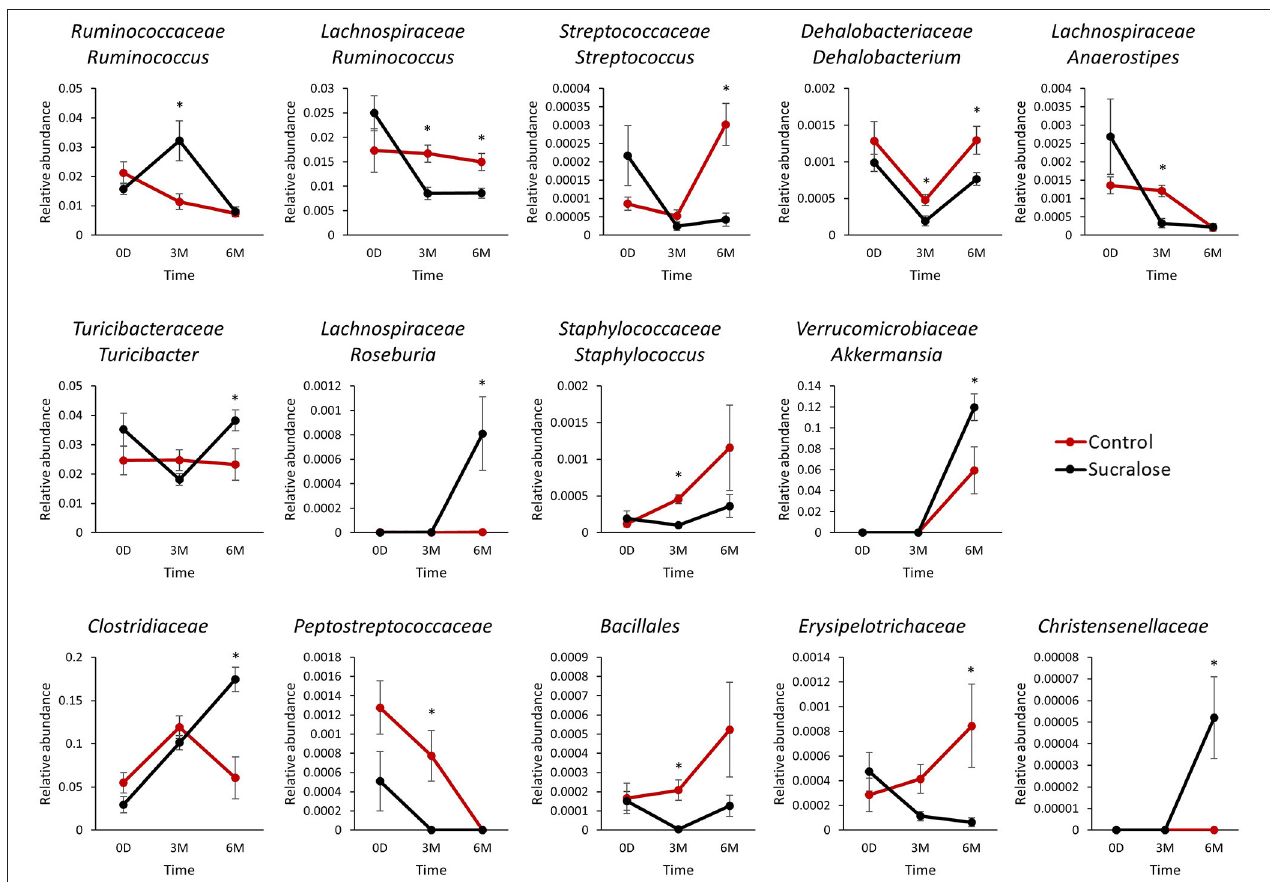
FIGURE 1 | Sucralose altered the dynamics of gut microbiome development in C57BL6/J mice. Bacterial genera exhibited different patterns over time between the control and sucralose-treated mice. * p <